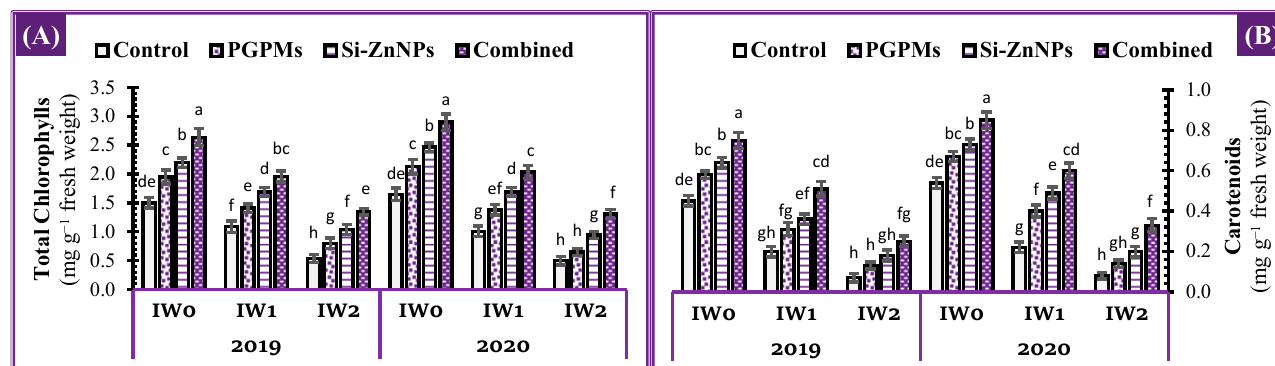
Figure 3. Influence of application of PGPMs, Si-ZnNPs and their combination on the concentration of ( A ) total chlorophylls, and ( B ) carotenoids in the leaves of soybean plant grown in salt-affected soil with different levels of watering intervals ( IW 0 ; 11 days, IW 1 ; 15 days, and IW 2 ; 19 days) during the successive 2019 and 2020 growing seasons. The data presented as means ± SD. Means labeled with the same lower-case letter are not significantly different according to Duncan’s Multiple Range Test.